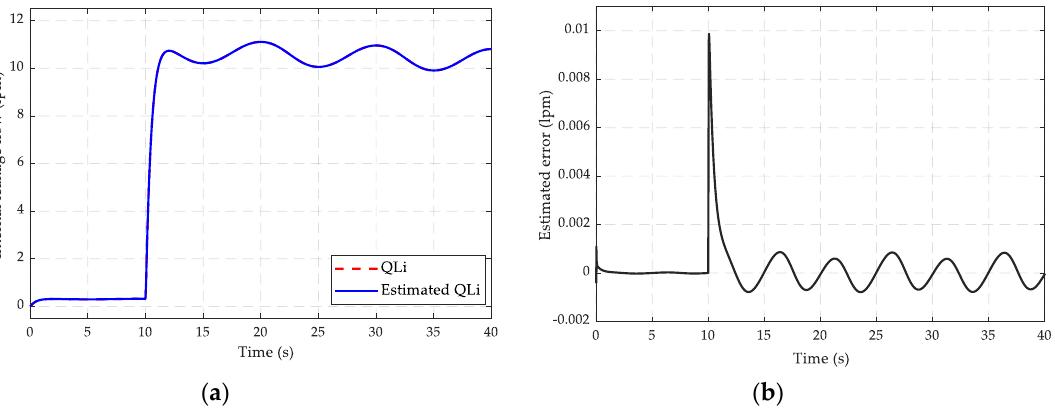
Figure 10. Comparison of estimated internal leakage flow. ( a ) Estimated result. ( b ) Estimated error.